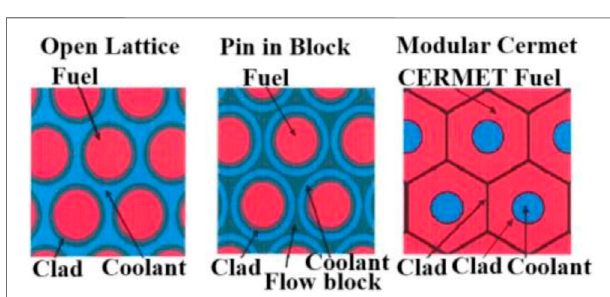
FIGURE 2 | Geometrical options mentioned in the Prometheus Research Program (Wollman and Zika (Apr, 2006)).